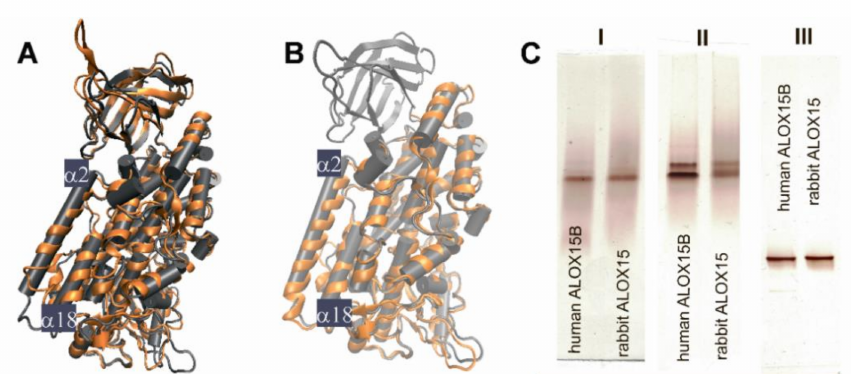
Figure 1. ( A ) Overlay of crystal structures of rabbit ALOX15 (PDB entry 2P0M, conformer A, grey) and human ALOX15B (PDB entry 4NRE, brown). ( B ) Overlay of crystal structures of rabbit ALOX15 (PDB entry 2P0M, conformer A, grey) and the AA 12-lipoxygenating porcine ALOX15 catalytic do- main (PDB entry 3RDE, brown). ( C ) Structural heterogeneity of rabbit ALOX15 and human ALOX15 B in salt-free aqueous solutions. (C-I) Native polyacrylamide gel electrophoresis (PAGE). For this analy- sis, the enzymes were prepared and maintained in 20 mM Tris-HCl buffer, pH 8.0 containing 130 mM NaCl. (C-II) Native PAGE. For this analysis, the enzyme was prepared and maintained in 20 mM Tris-HCl buffer, pH 8.0 that does not contain NaCl (desalted enzyme preparation eluted as a single peak by and size-exclusion chromatography). (C-III) Denaturing PAGE. For this analysis the enzyme was prepared and maintained in 20 mM Tris-HCl buffer, pH 8.0, but the running buffer contained 0.5%